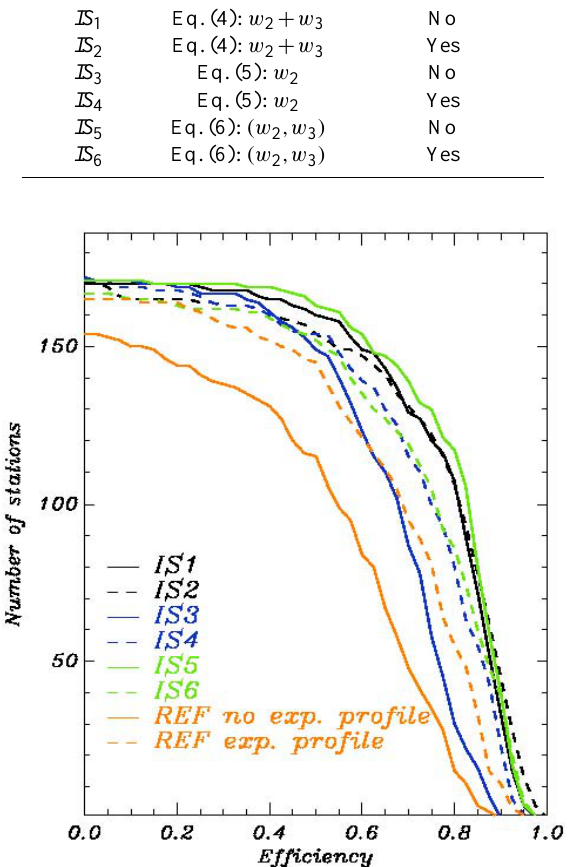
Fig. 4. Accumulated distribution of efficiency for the 186 assimilated stations. These plots represent the number of stations (y-axis value) whose efficiency (Nash criterion) is over the relative x-axis value. Solid lines are the experiments without the exponential profile of hydraulic conductivity. Dashed lines are the experiments with the exponential profile of hydraulic conductivity.